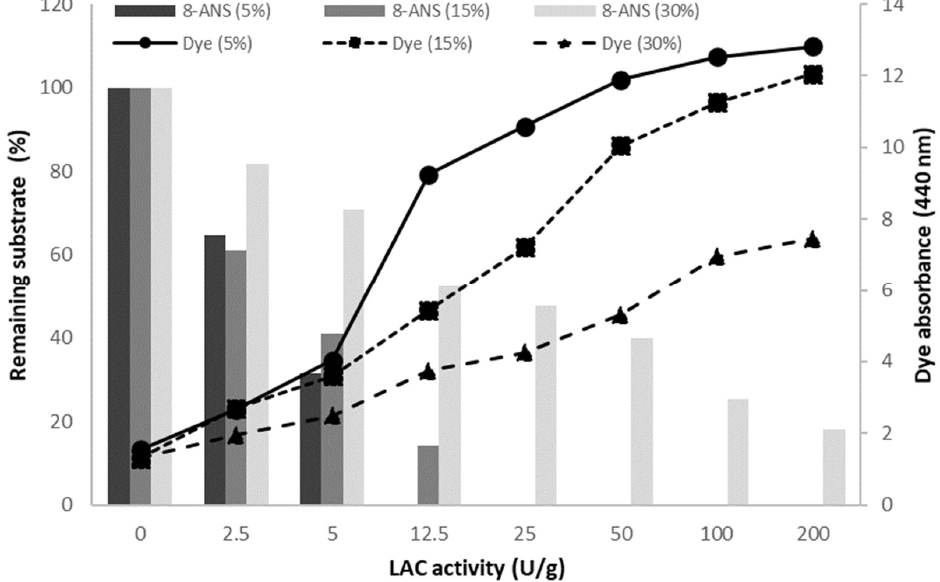
Figure 2. Effect of the methanol amount (in brackets: 5%, 15%, and 30% v / v total methanol concen- tration) and LAC activity (2.5–200 U/g: U per gram of ANS) on the yield of ANS oxidation (columns) and absorbance of the dye (lines) obtained after 24 h transformation of ANS (1 g/L) by LAC.